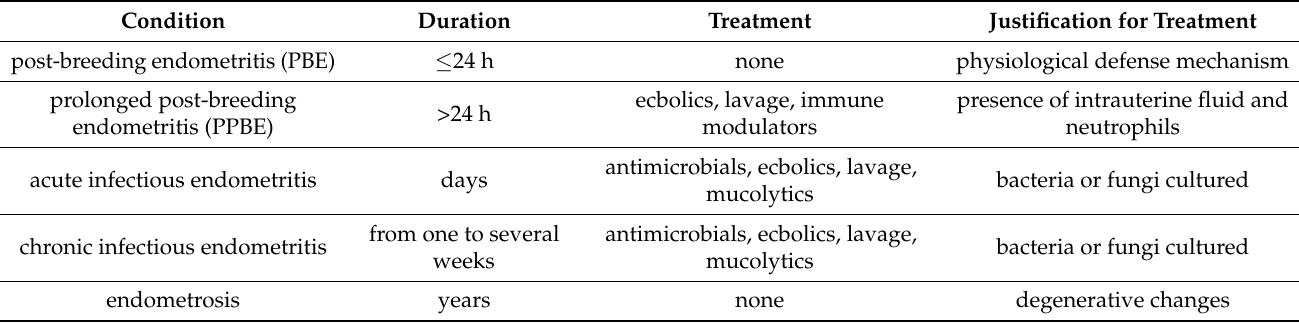
Table 1. Classification and treatment of endometrial